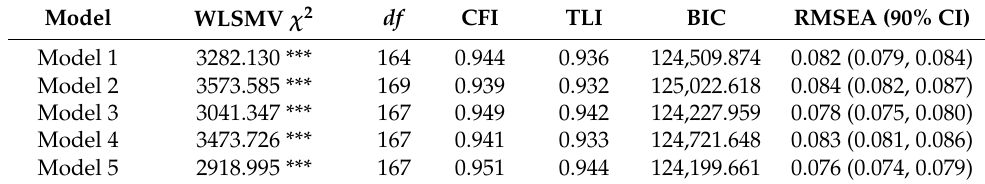
Table 3. Model comparisons for tested models using the half sample B at Wave 1 ( n =